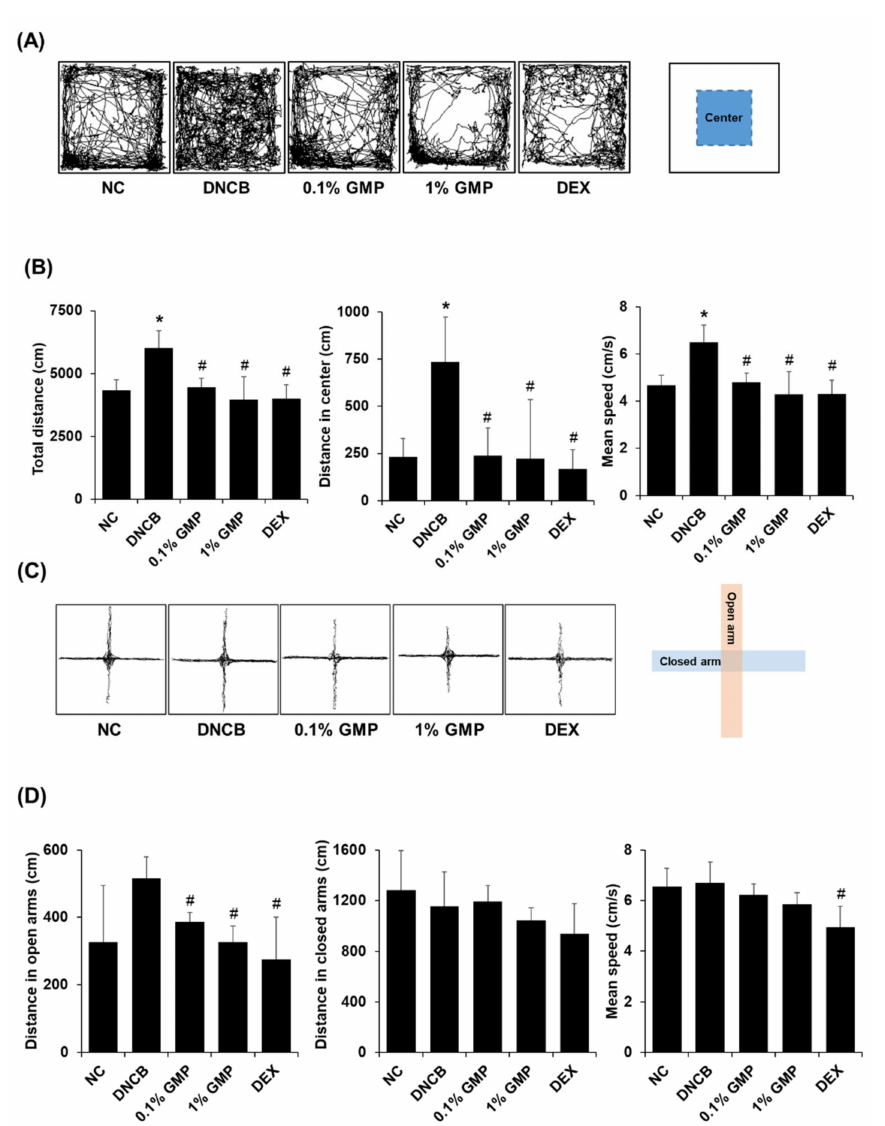
Figure 4. Effect of GMP on behavioral changes in DNCB-treated BALB/c mice. ( A ) Representative tracking images of each group in the OFT. ( B ) Total distance, distance in center, and mean speed in the OFT were assessed on day 36. ( C ) Representative tracking images of each group in the EPM. ( D ) Distance in open arms, closed arms, and mean speed in the EPM were assessed on day 38. Data represent the means ± SDs. * p < 0.05 vs. the NC group, # p < 0.05 vs. the DNCB